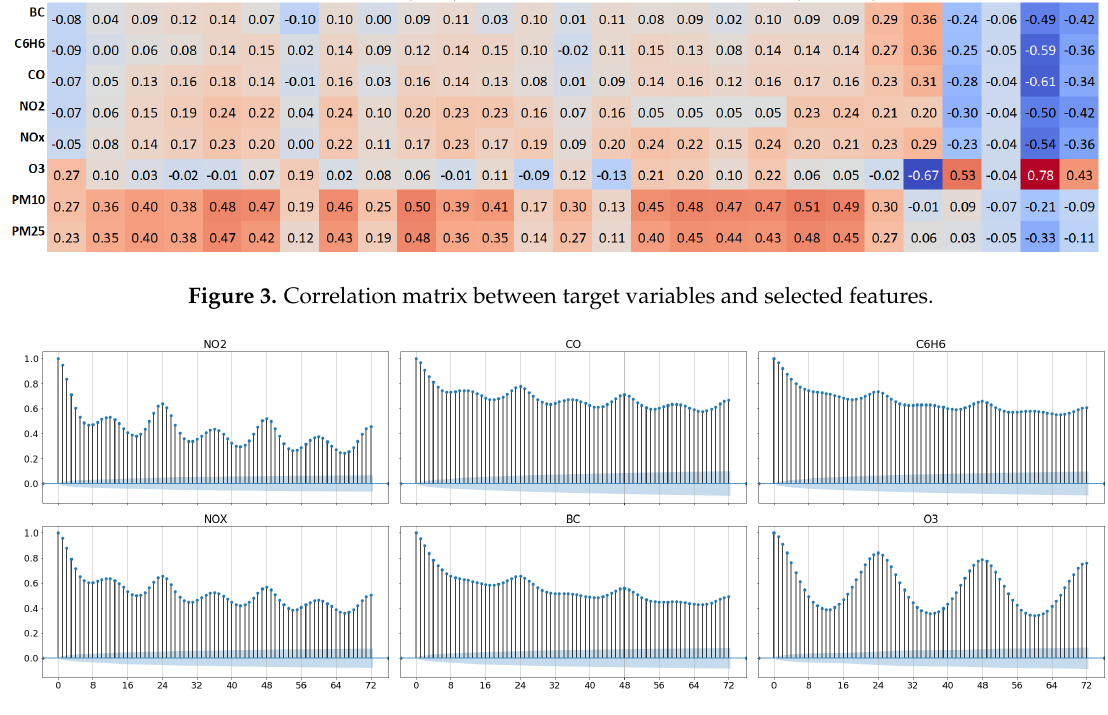
Figure 4. Autocorrelation for the hourly pollutants considered in the case study, over a time window of 72